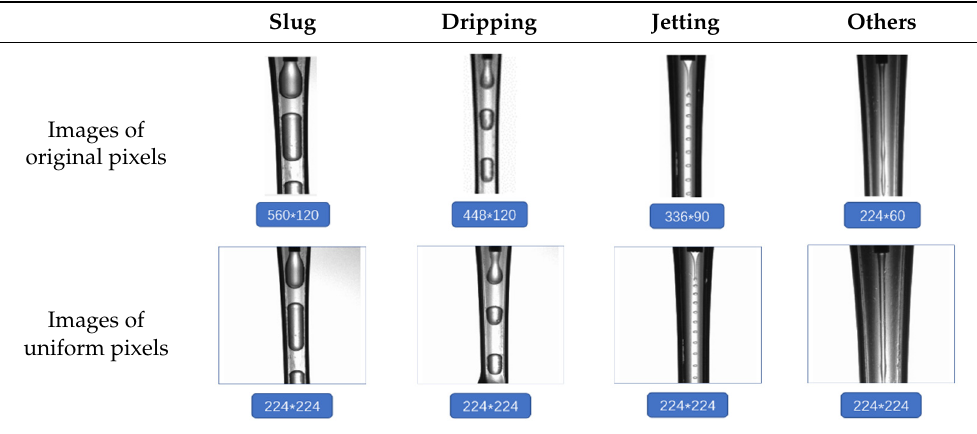
Table 3. Original pixels transformed into uniform pixels.